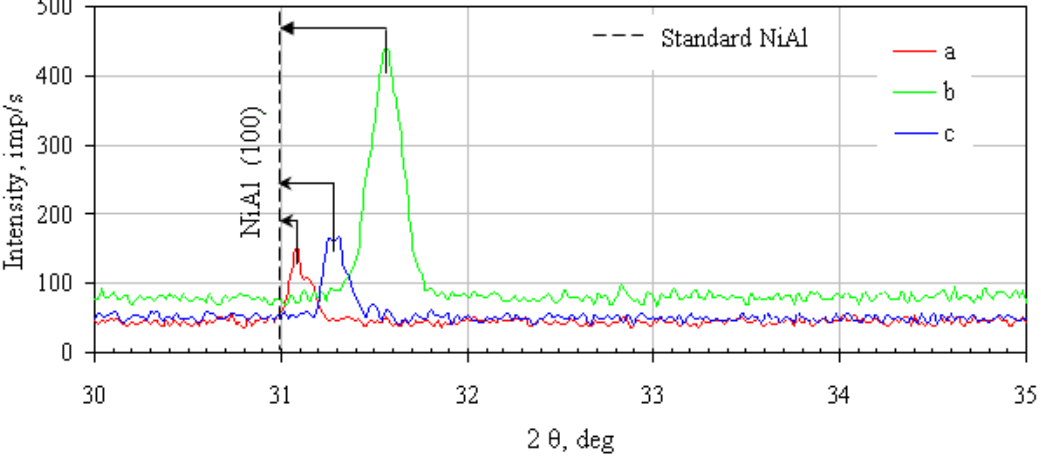
Figure 3. X-ray diffraction (XRD) patterns of the nonmodified ( a ), rhodium-modified ( b ) and rhodium- and hafnium-modified ( c ) aluminide coatings.